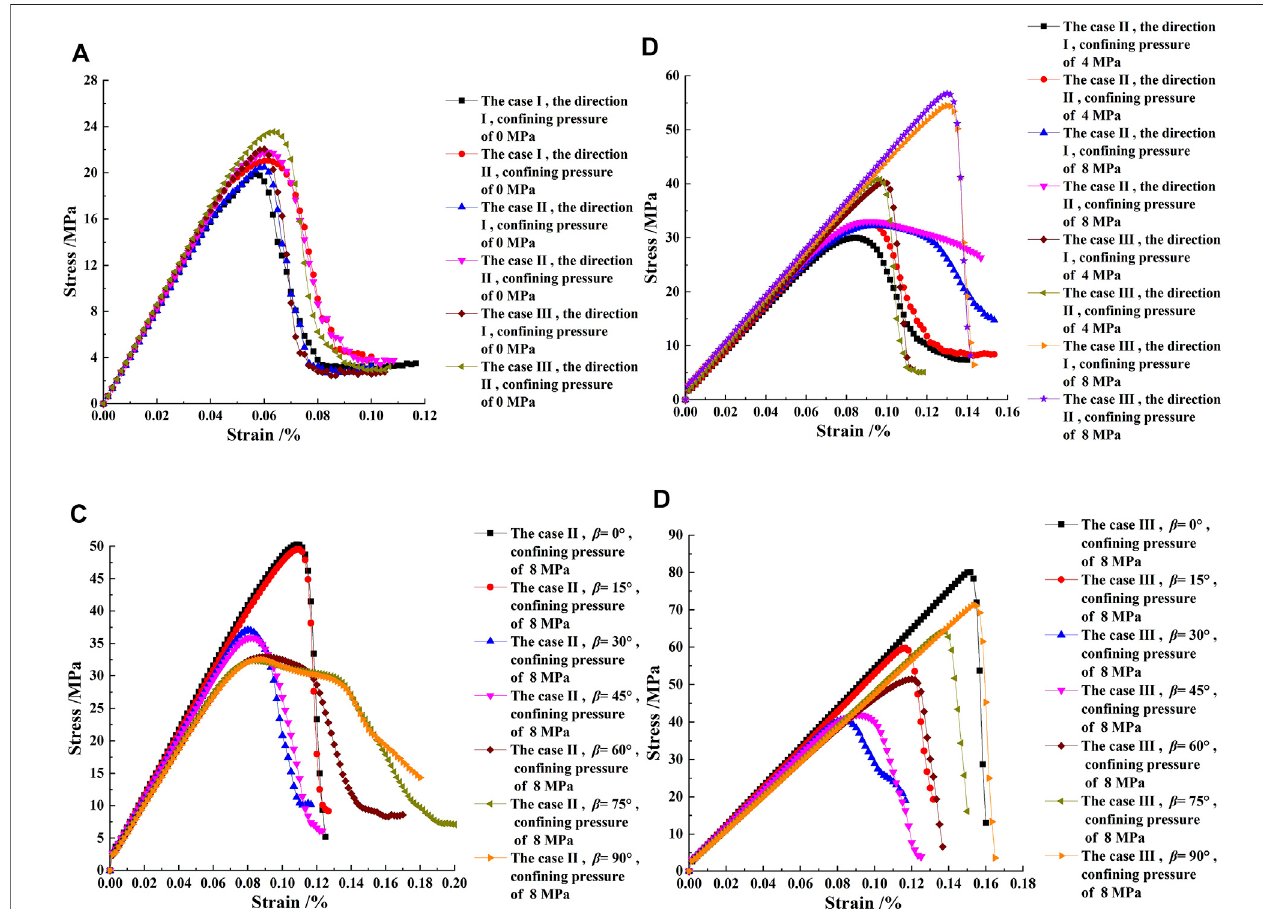
FIGURE 6 | (A) The stress – strain curves of columnar jointed basalts (CJBs) with different model boundaries and a con fi ning pressure of 0 MPa in the direction orthogonaltothecolumnaxis. (B) Con fi ningpressuresof4and8 MPa. (C,D) Thestress – straincurvesofCJBswithdifferentmodelboundariesandacon fi ningpressure of 8 MPa in the direction parallel to the column axis (case I, case II, and case III correspond to the case of plane stress, the case between plane stress and plane strain, and the case of plane strain, respectively).